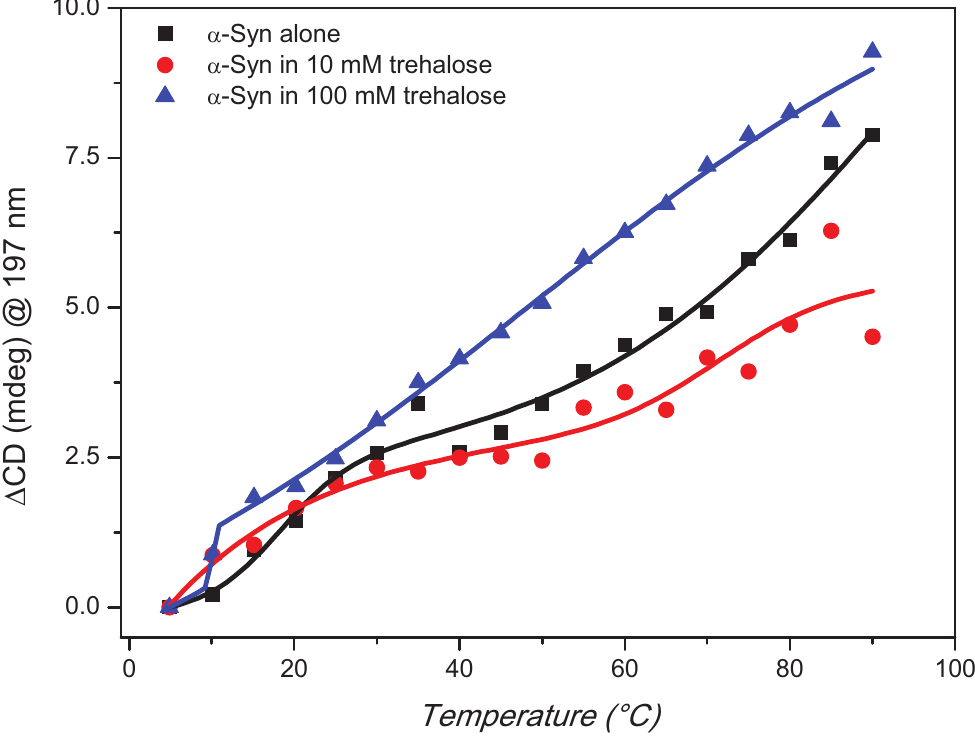
Figure 4. CD melting curves of (cid:2)-synuclein alone or in presence of 10 or 100 mM trehalose using biDoseResp curve fitting from OriginLab software with R 2 of 0.98, 0.89 and 0.99